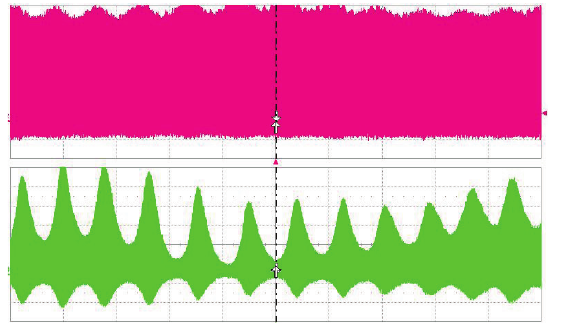
Figure 9. Oscillogram—unstable dual-pulse regime. 1.06 µ m pump (upper trace), PPLN OPO radiation at 1.53 µ m (lower trace). Time scale 1 µ